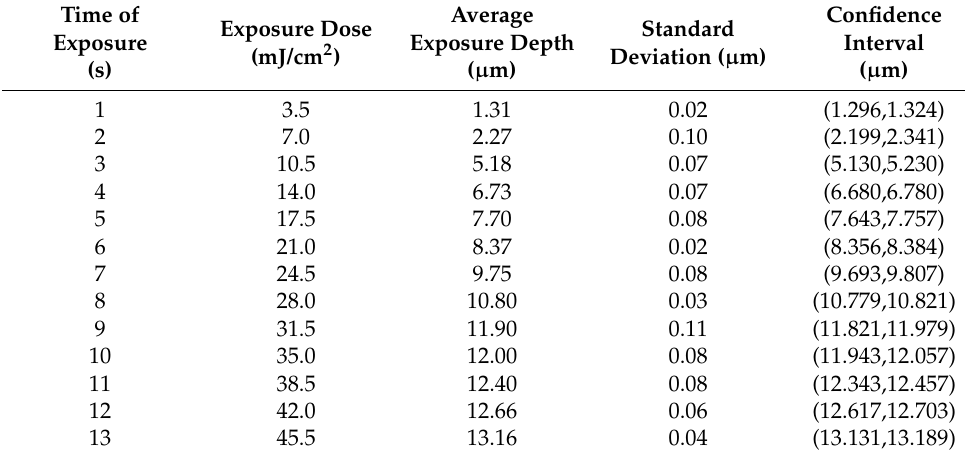
Table 2. Exposure depth data under different exposure doses. Time